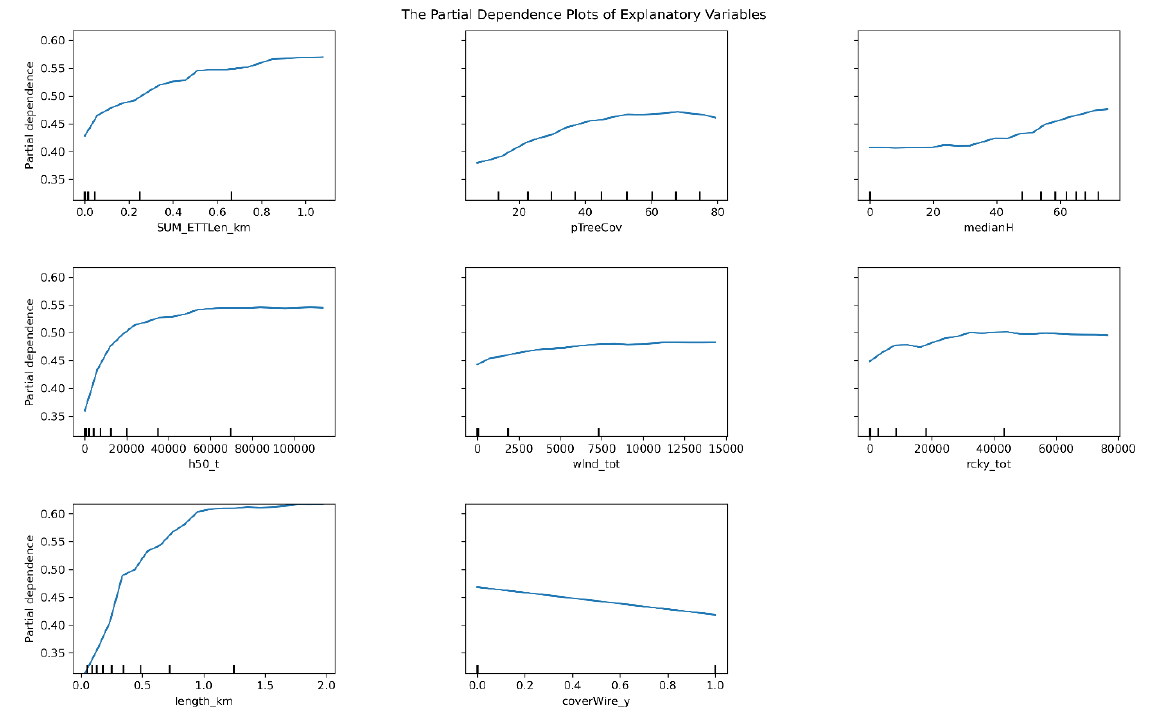
Figure 7. The partial dependence plots for highest importance